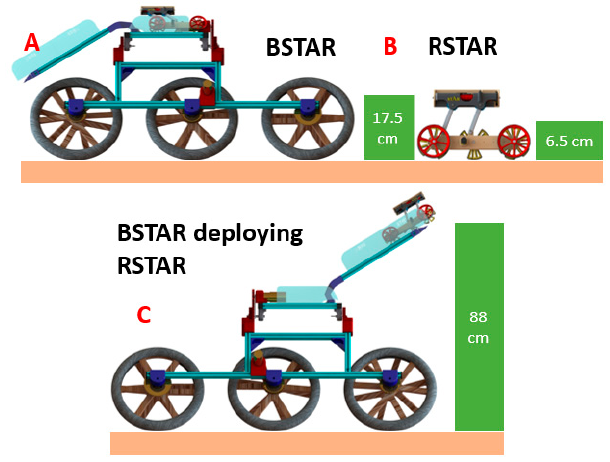
Figure 12. The maximum height of obstacles the robot can overcome. ( A ) BSTAR. ( B ) RSTAR. ( C ) RSTAR getting a boost up from BSTAR.